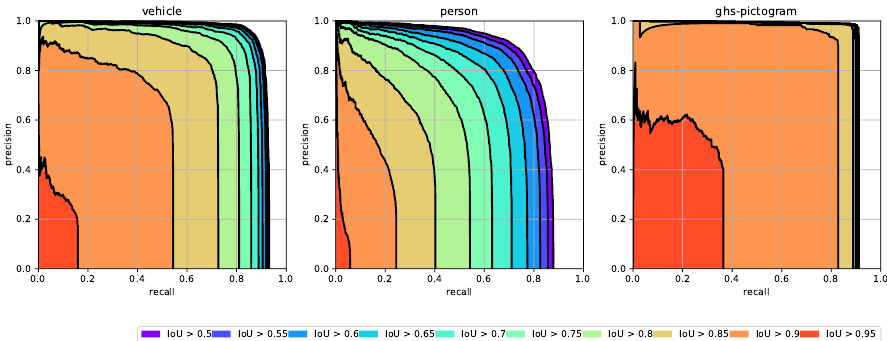
Figure 6. The precision–recall curve of object detection for individual classes.